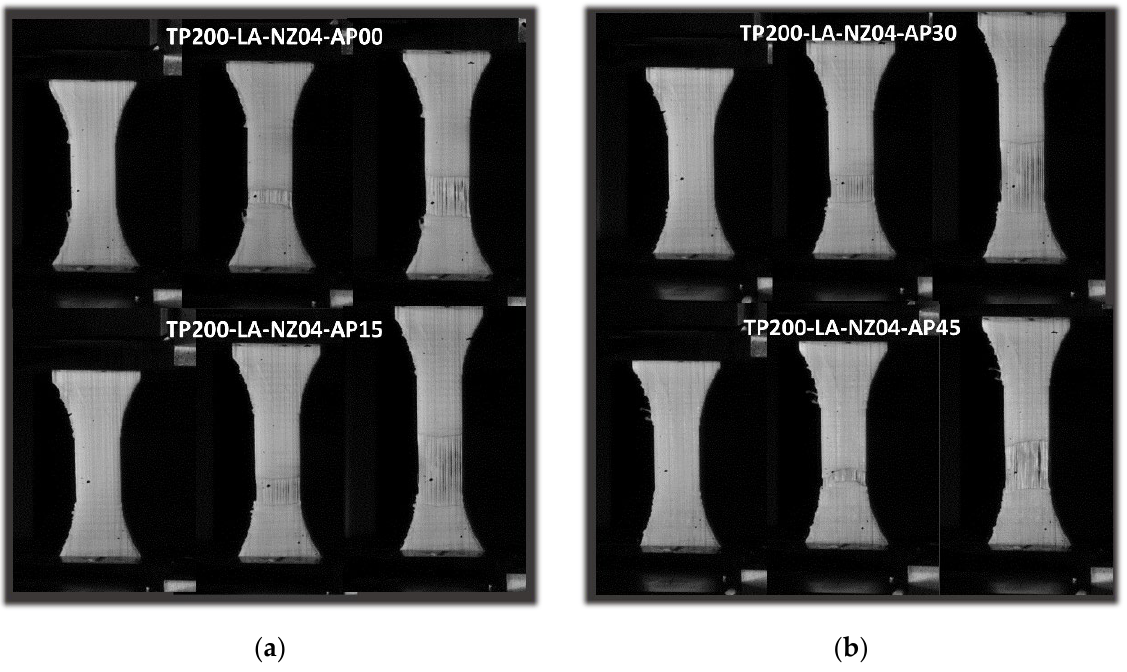
Figure 15. Effect of lateral orientation (LA) on tensile behaviour of PLC for different in-plane printing angles: ( a , b ) close-up view of filament and 3D-printed PLC sample.